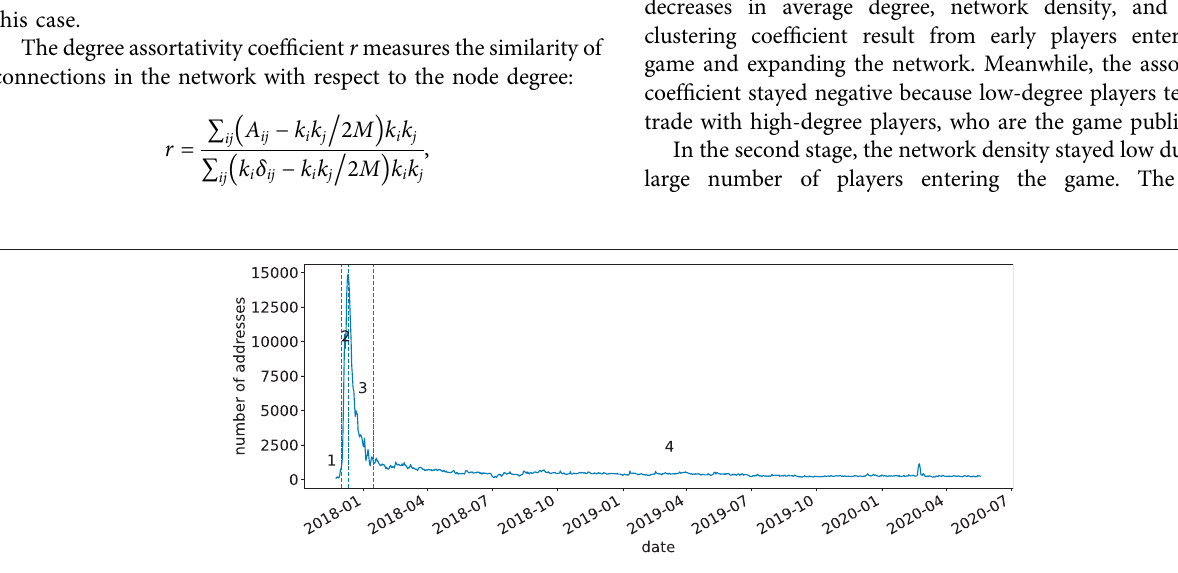
Frontiers in Physics |